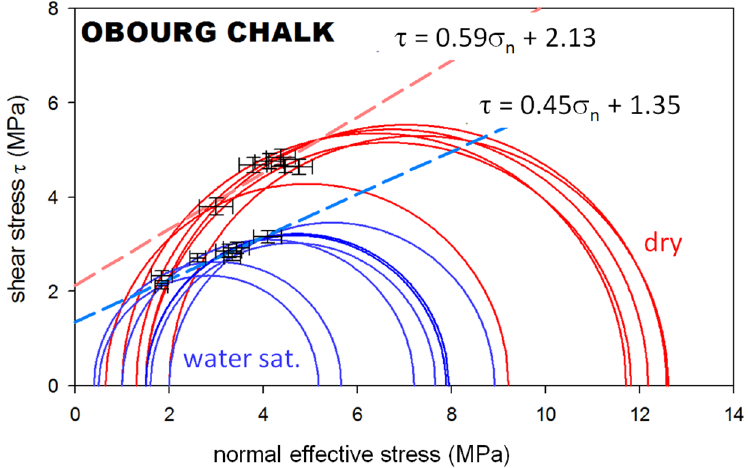
Figure 11. Mohr circles obtained from triaxial tests on dry (in red) and water-saturated (in blue) Obourg Chalk samples. The Coulomb failure lines were derived by a least-squares fitting scheme using the points with error bars on the plot.